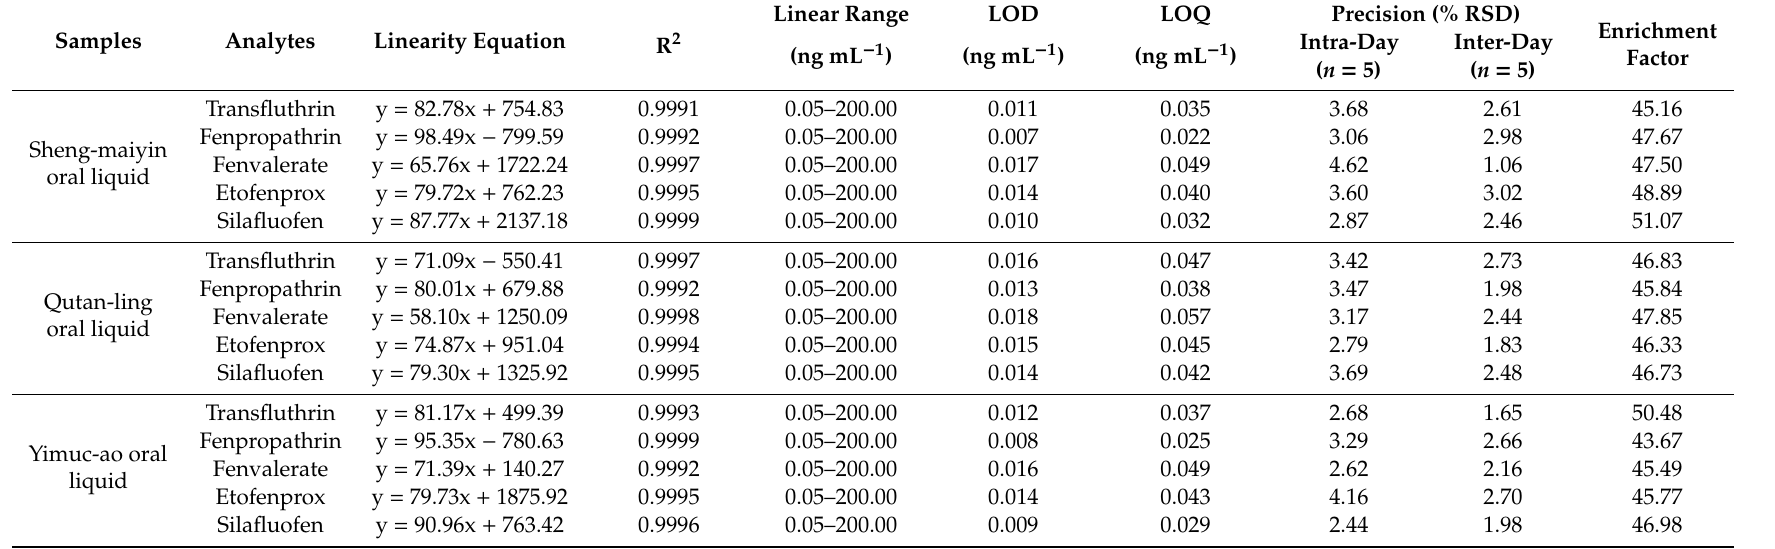
Table 1. Analytical performance optimized for determination of pyrethroids by QuEChERS method combined with high-performance liquid chromatography and ultraviolet detection (HPLC-UV). LOD: limits of detection; LOQ: limits of